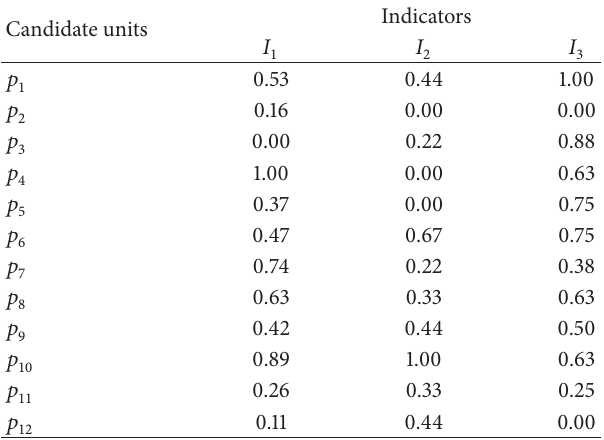
Table 5: Standardized initial information of individual indicators of candidate